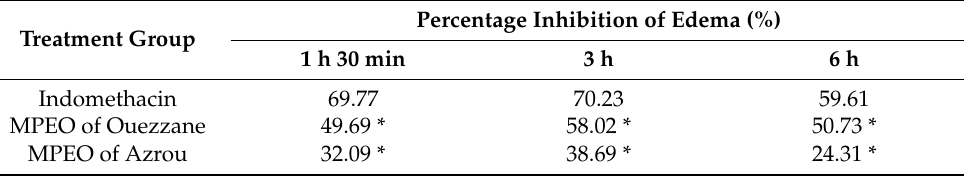
Table 5. Percentage of inflammation inhibition by M. pepirita on carrageenan-induced rat paw edema. Treatment